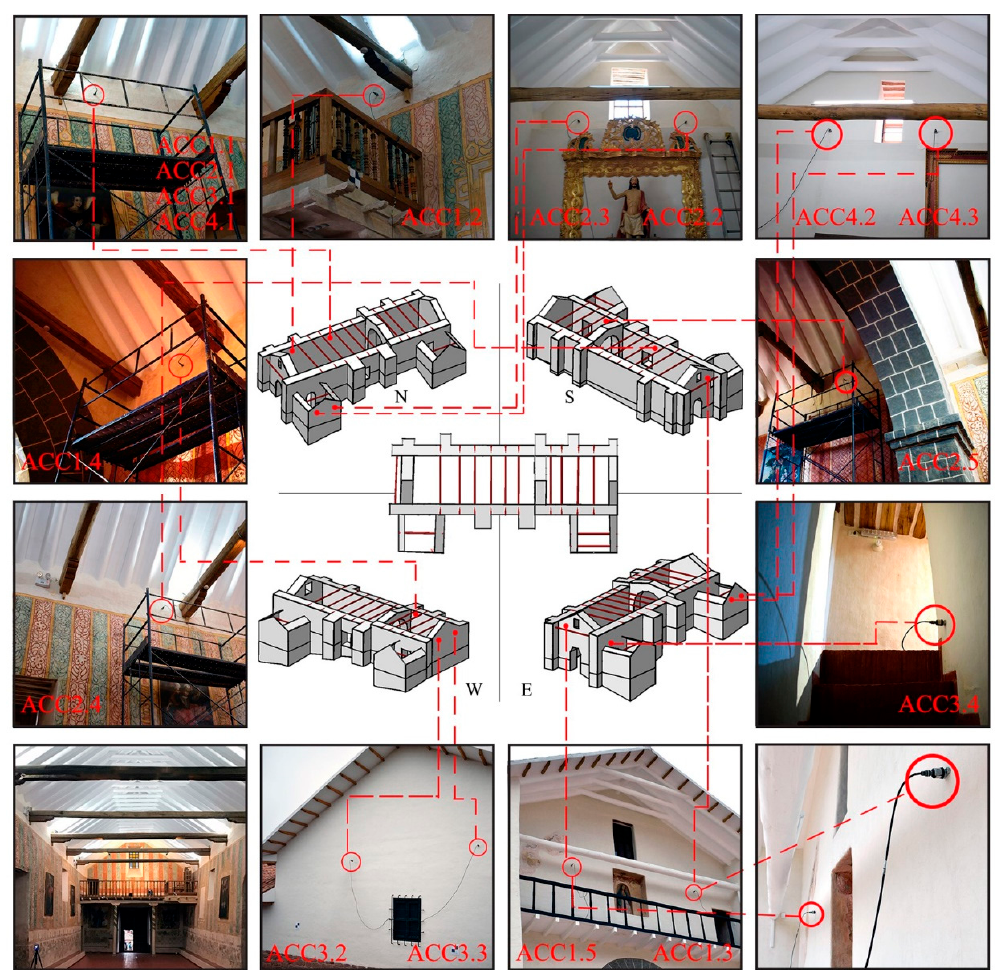
Figure 10. Dynamic identification tests in the retrofitted Church of Kuñotambo: placement of accelerometers at the nave, presbytery, altar, baptistery and sacristy gable walls.